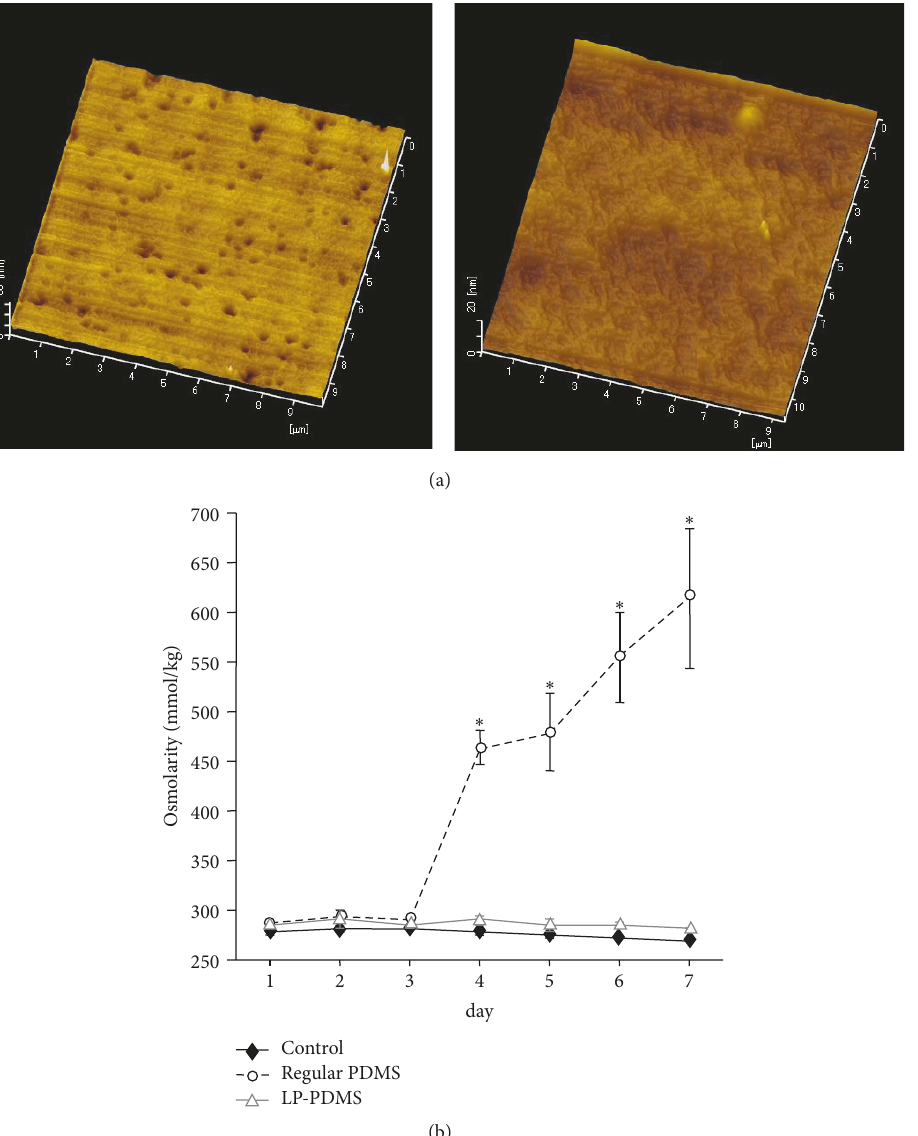
Figure 2: Characteristics of PDMS plate cured under low pressure. (a) AFM images of the surfaces of regular and LP-PDMS plates. (Left) Regular PDMS plate cured under atmospheric pressure. (Right) LP-PDMS plate cured under low pressure (-0.08 MPa). Scale bar: 1 𝜇 m. (b) Effect of PDMS curing conditions on osmolality of culture medium in regular and LP-PDMS MW. Culture medium added to plastic dish was used as a control. Asterisks were denoted significant differences between regular PDMS MW group (open circle) and other groups (LP-PDMS MW group; open triangle and control; closed diamond) in each Day (P < 0.05).